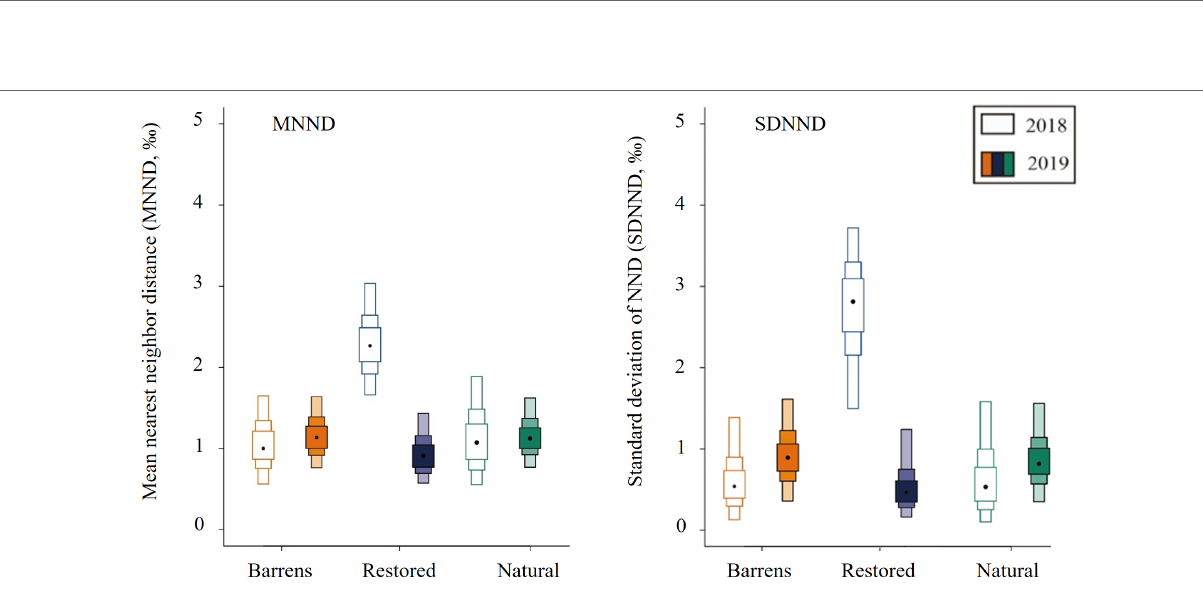
FIGURE 7 | Two community metrics (mean nearest neighbor distance and standard deviation of the nearest neighbor distance) in a Bayesian model presenting information on trophic redundancy within a food web 2018 data and 2019 data are respectively represented by empty squares and colored